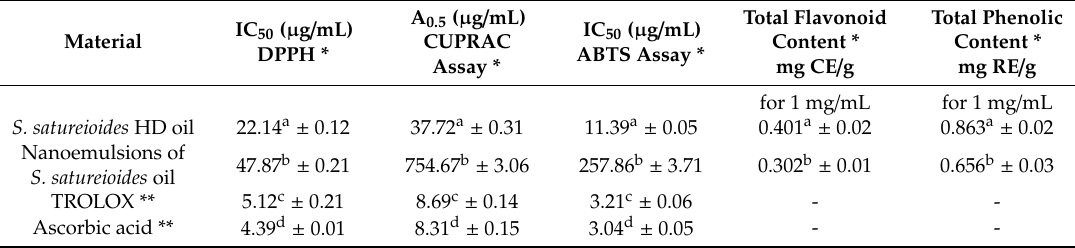
Table 2. Activity of HD and nanoemulsions of S. satureioides essential oil in comparison to the antioxidant